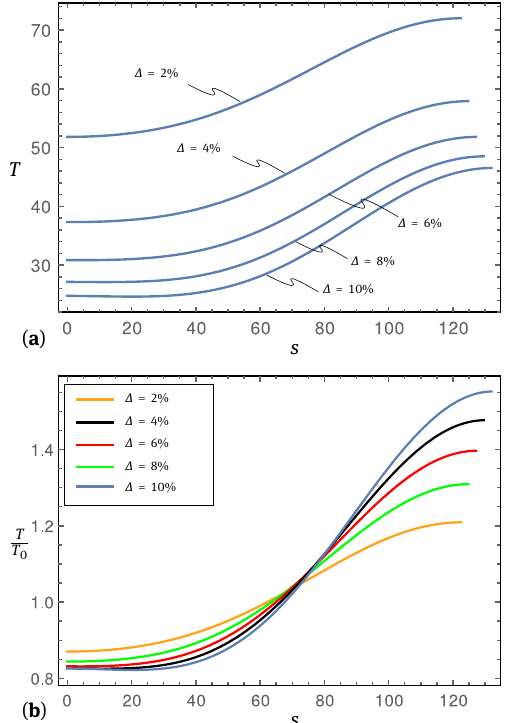
Figure 3: Suspended cable: (a) Modulus of the tension T and (b) tension ratio T ( s )/ T 0 , for different values of ∆ ; [ s ] = m , [ T ] = kN .